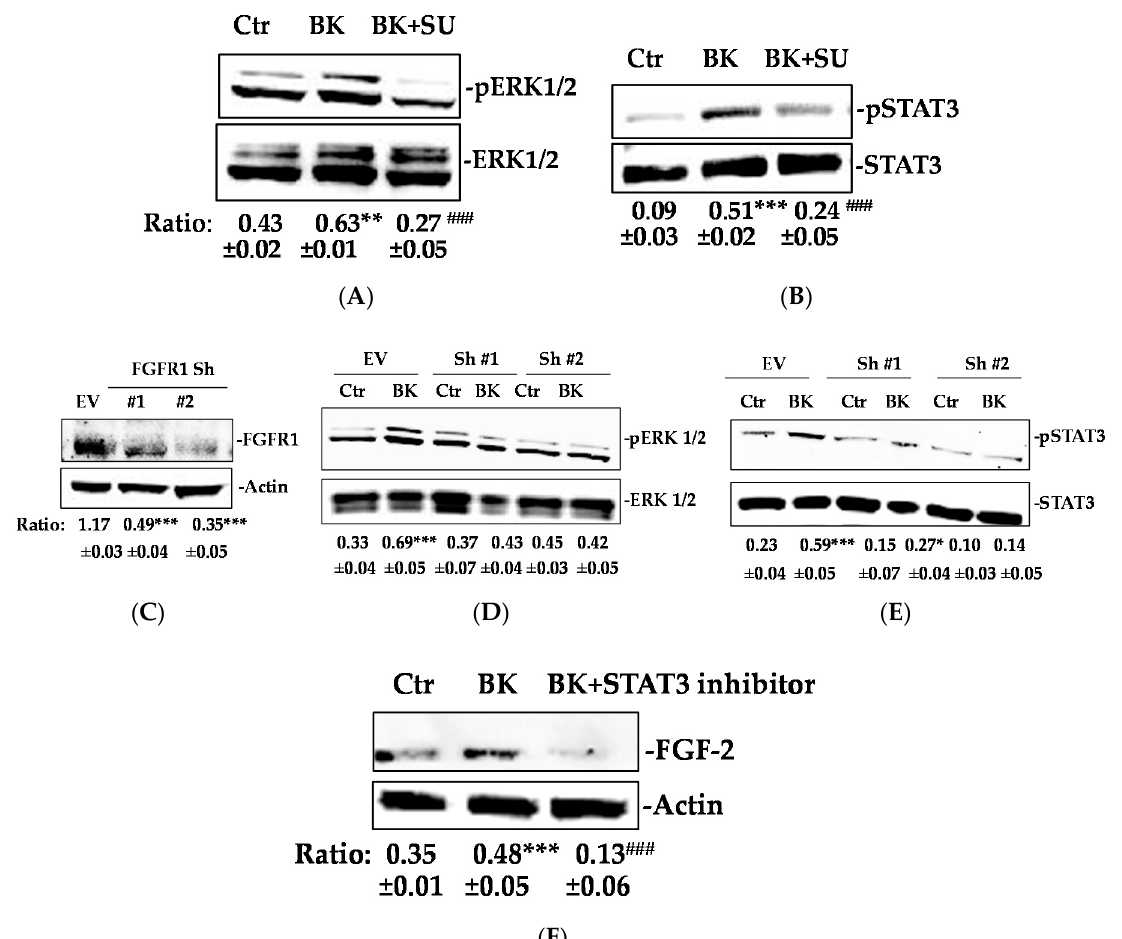
Figure 3. BK-mediated ERK1/2-STAT3/FGF-2 signaling activation requires FGFR-1. ( A ) ERK1/2 and ( B ) STAT3 phosphorylation were evaluated using western blot analysis in HUVEC treated with SU5402 (1 µ M, 30 min), then stimulated with BK (1 µ M) for 15 min. Results were normalized to ERK1/2 and STAT3, respectively. ( C ) FGFR-1 expression evaluated using western blot analysis in HUVEC transfected with two different shRNA for FGFR-1 knock-down (Sh#1 and Sh#2). EV = empty vector. ( D , E ) Western blot analysis for ERK1/2 and STAT3 phosphorylation in HUVEC transfected with Sh#1 and Sh#2 and stimulated with BK (1 µ M) for 15 min. ( F ) FGF-2 expression was evaluated in HUVEC treated with STAT3 inhibitor (10 µ M, 30 min) and then stimulated with BK (1 µ M) for 24 h. Actin was used as a loading control. The results presented are representative of three independent experiments ( n = 3) with similar results. Quantification was expressed as an arbitrary density unit (ADU). ** p < 0.01; *** p < 0.001 vs. Ctr; ### p < 0.001 vs. BK treated cells.